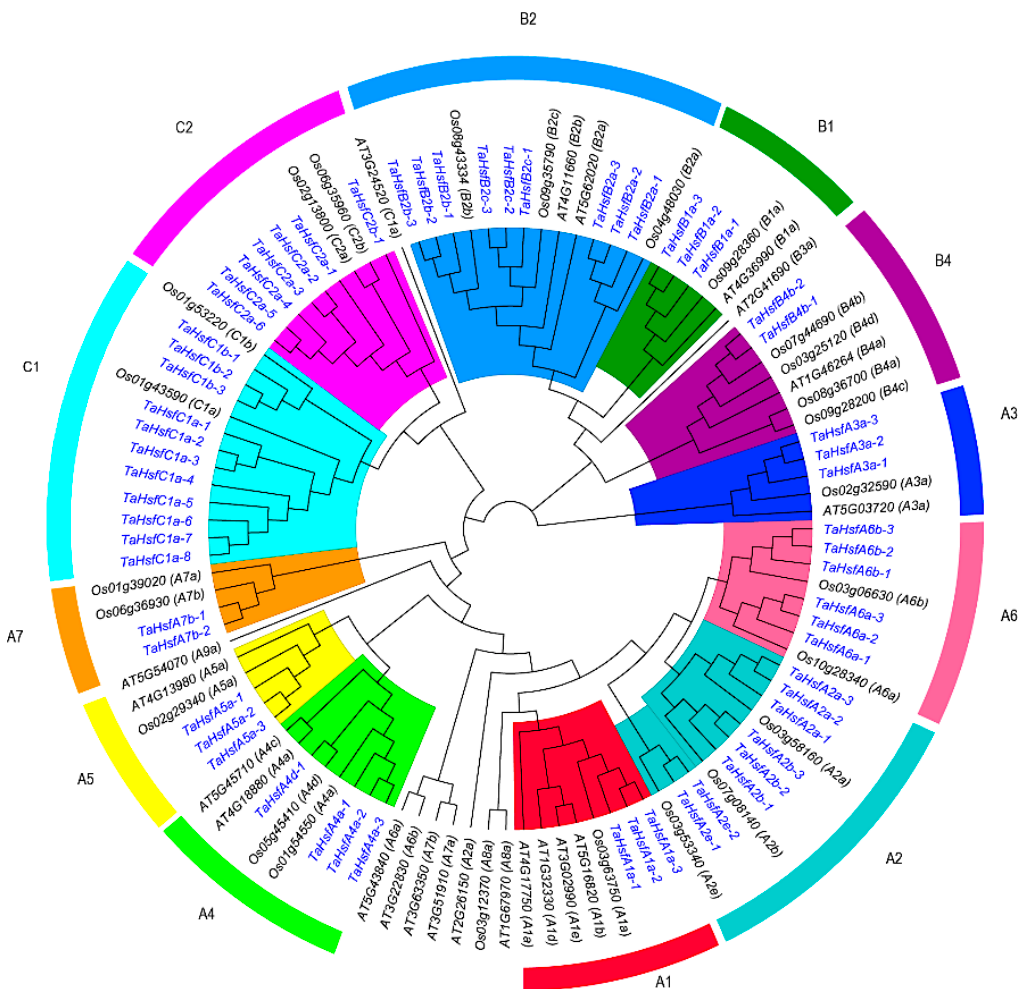
Figure 2. Phylogenetic tree obtained for the heat shock transcription factor (HSF) family members in wheat, rice, and Arabidopsis. Different colors represent different sub-classes in the HSF gene family.